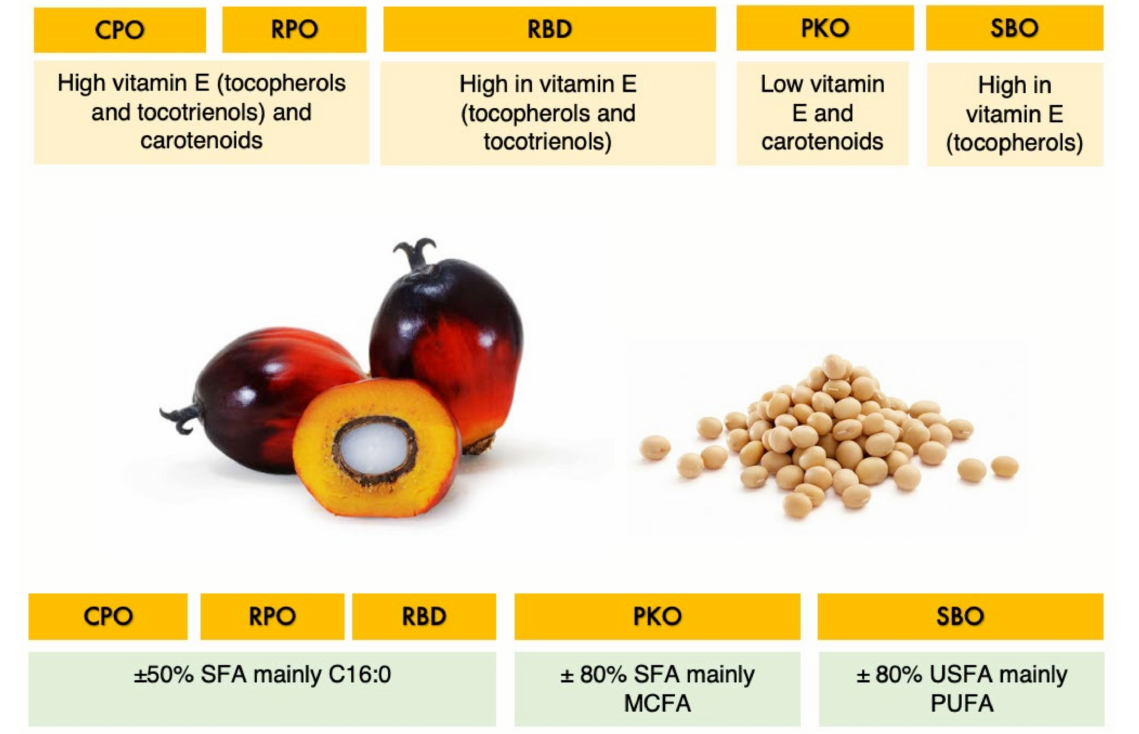
Figure 1. Summary of the properties of oil of